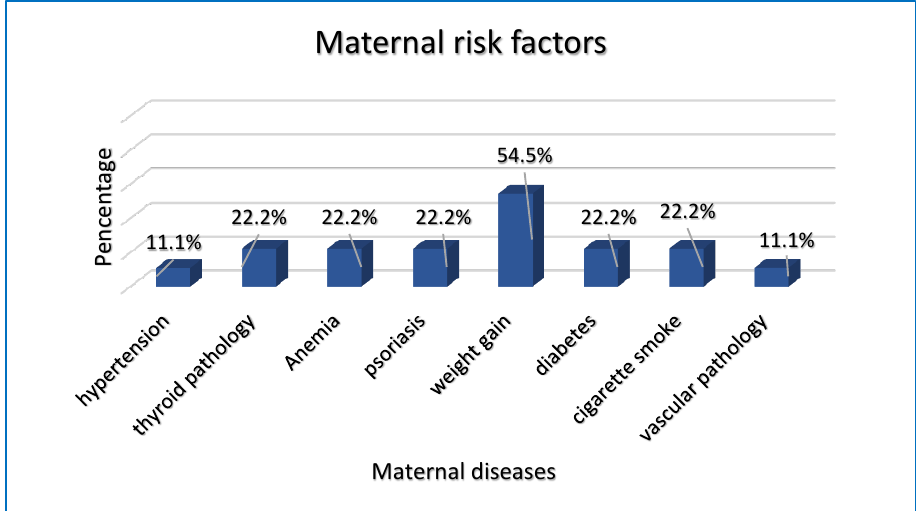
Figure 2. Maternal risk factors.